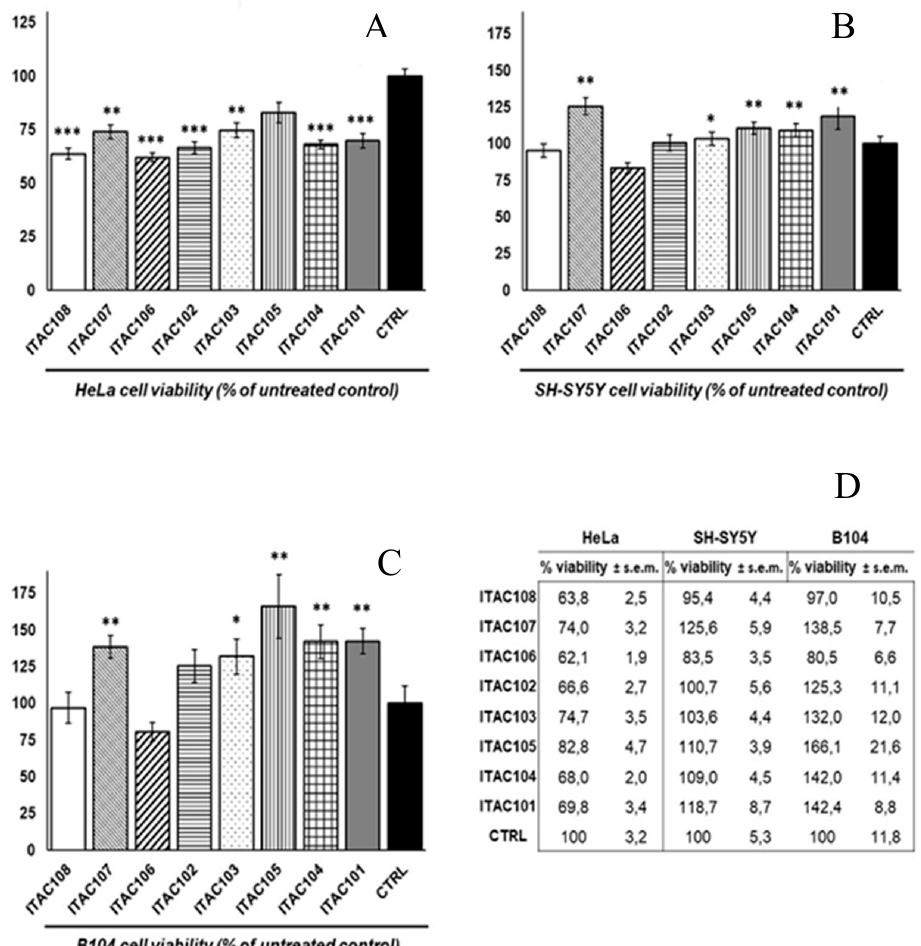
Figure 3. Effects of cyanobacterial aqueous cell supernatants on the viability of cultured cells evaluated by MTT assays on the human HeLa ( A ), SH-SY5Y cells ( B ) and the rat B104 cells ( C ), exposed for 6 h to cyanobacterial aqueous cell supernatants. In the graphs and the numerical table ( D ), data are represented as percentage (%) mean values ± s.e.m., with respect to the untreated control cells (CTRL, 100%). Data derive from three independent experiments, each with n = 8 biological replicates. Statistical analysis: Student’s t -test; differences vs. CTRL are indicated as statistically significant with p < 0.05 (*), p < 0.01 (**), or p < 0.001 (***).